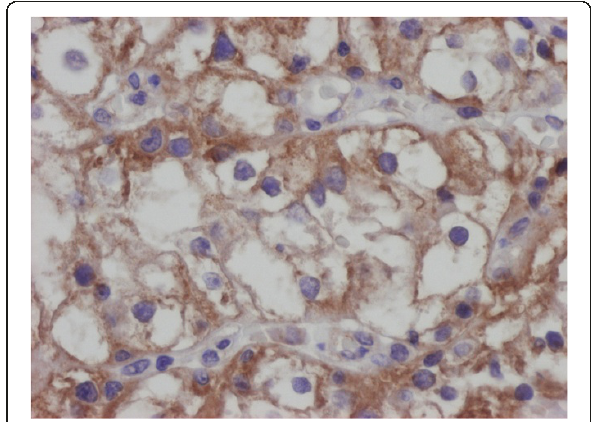
Figure 8 Positivity of RCC for the HLA-E, immunohistochemistry, DAB method, clone MEM-E/02, Exbio Prague. Analysed by Olympus BX45 microscope equipped with Olympus DP50 digital camera. Olympus Viewfinder Lite ™ software was used to acquire and process the image,